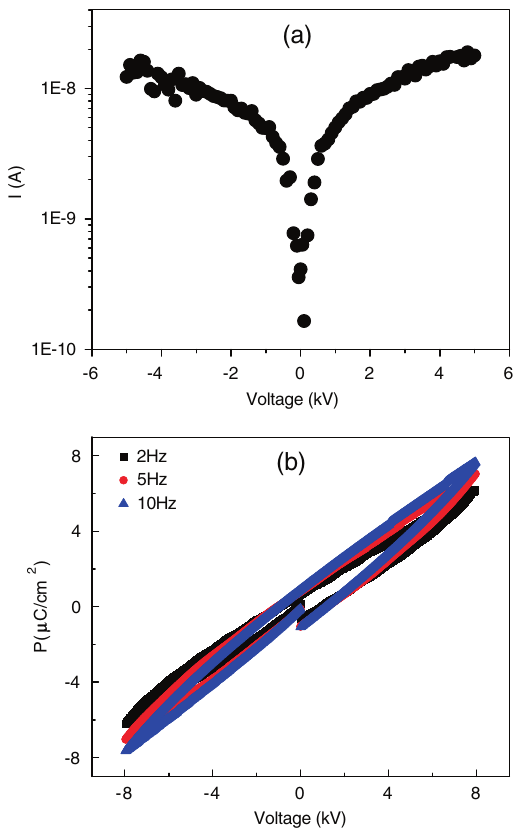
Fig. 4 a Leakage current behavior as function of applied electric fi eld, b nonlinear slim polarization under large stress E- fi